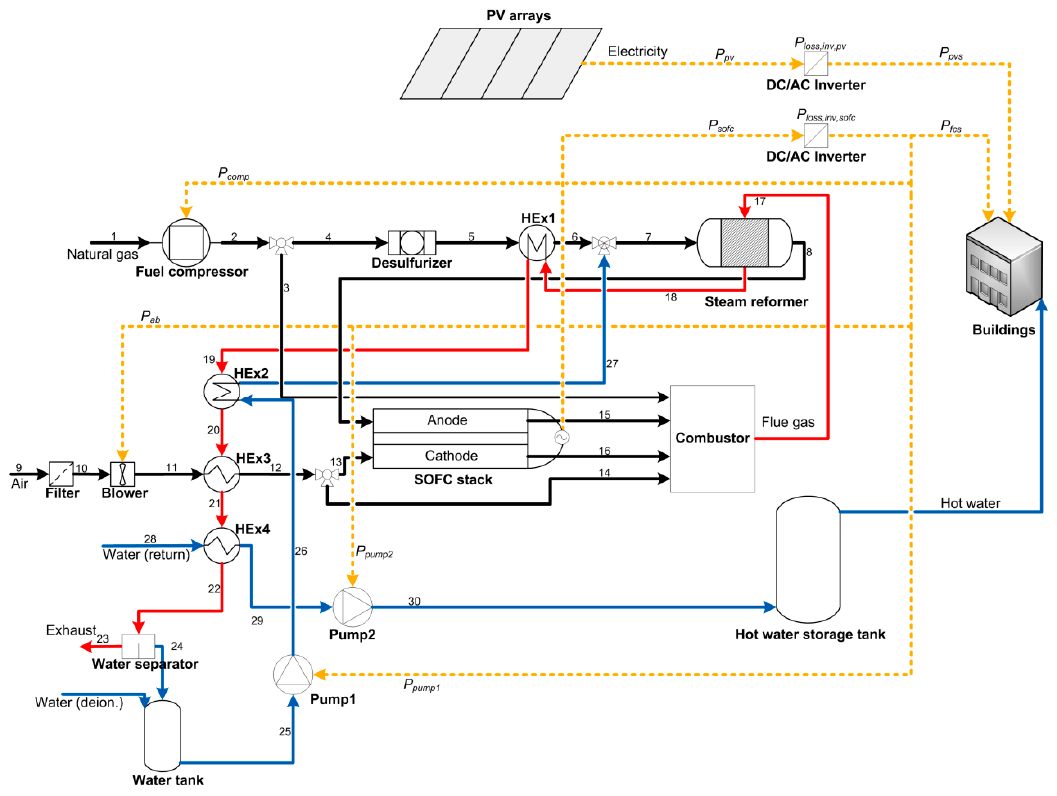
Figure 1. Schematic representation of the proposed hybrid photovoltaic-solid oxide fuel cell (PV-SOFC) system.